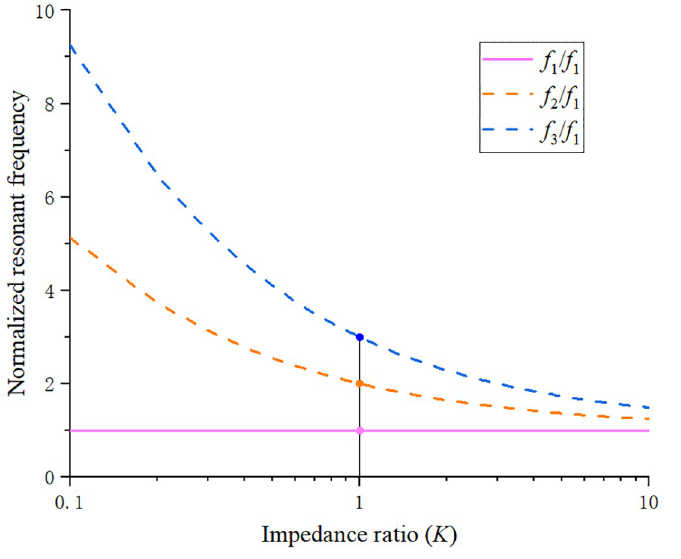
Fig 6. Relationship between normalized resonant frequency and impedance ratio.